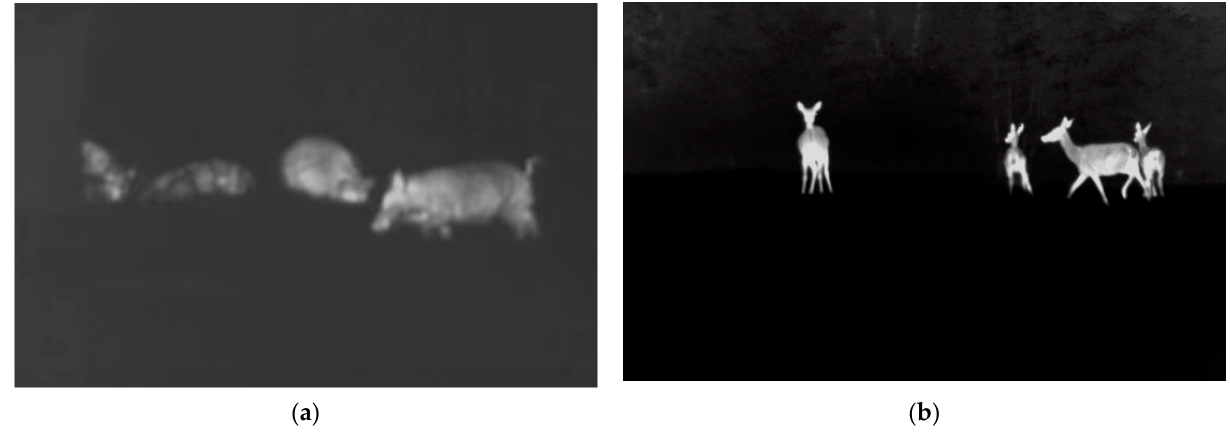
Figure 1. Examples of two distinguishable objects—( a ) “wild_boar”, ( b ) “deer”.